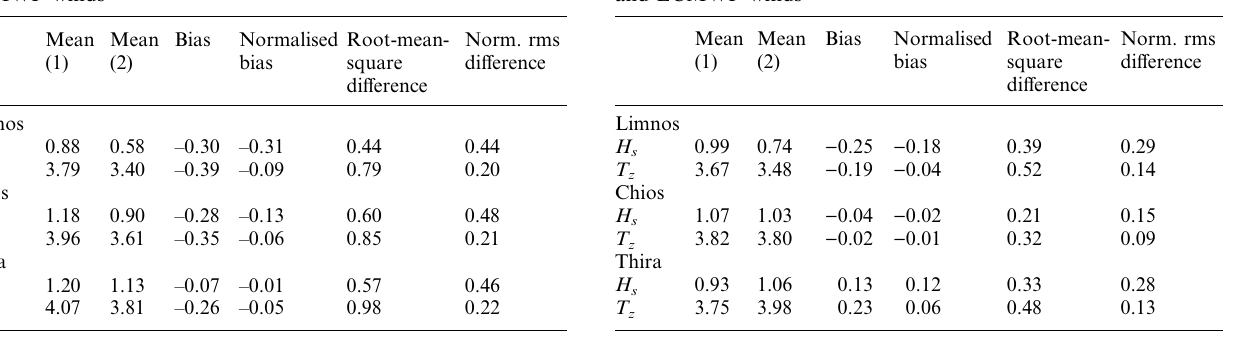
Table 10. Statistics for the storm December 1991, -128 points. Comparison of results from WAM-cy3 model using UKMO LAM